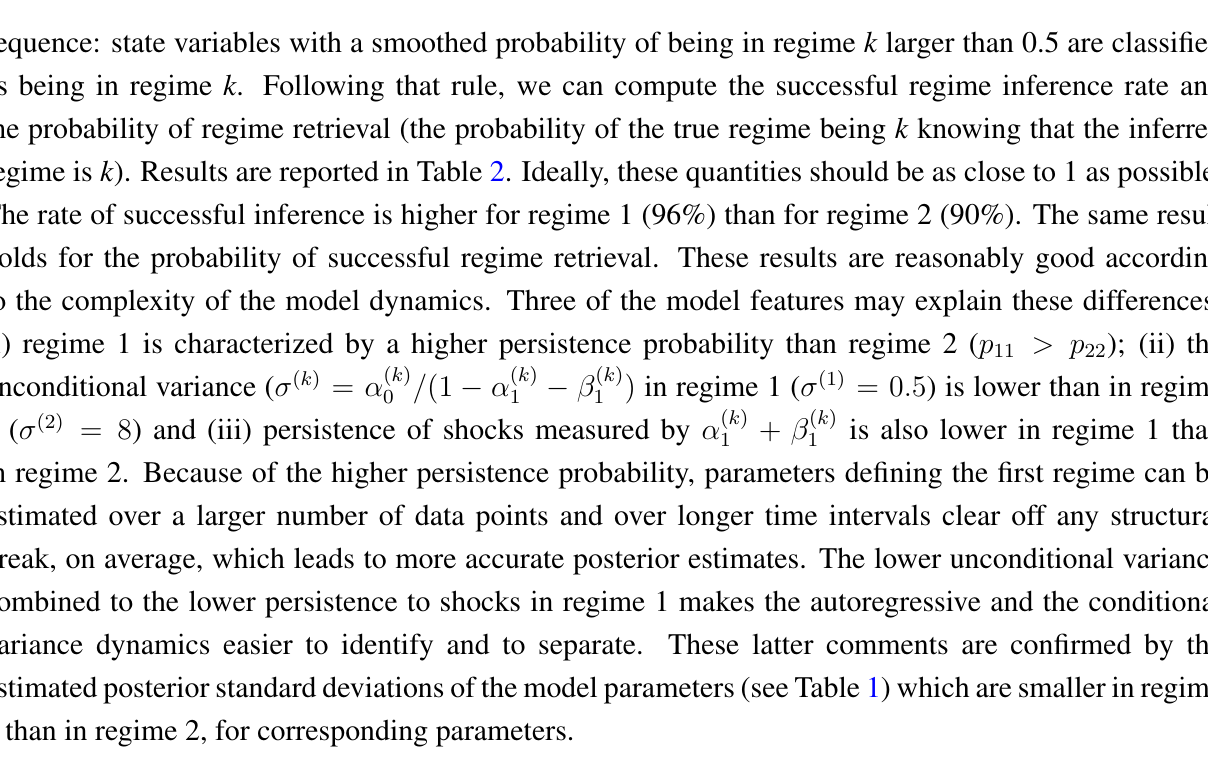
Table 2. Statistics on the inferred regime